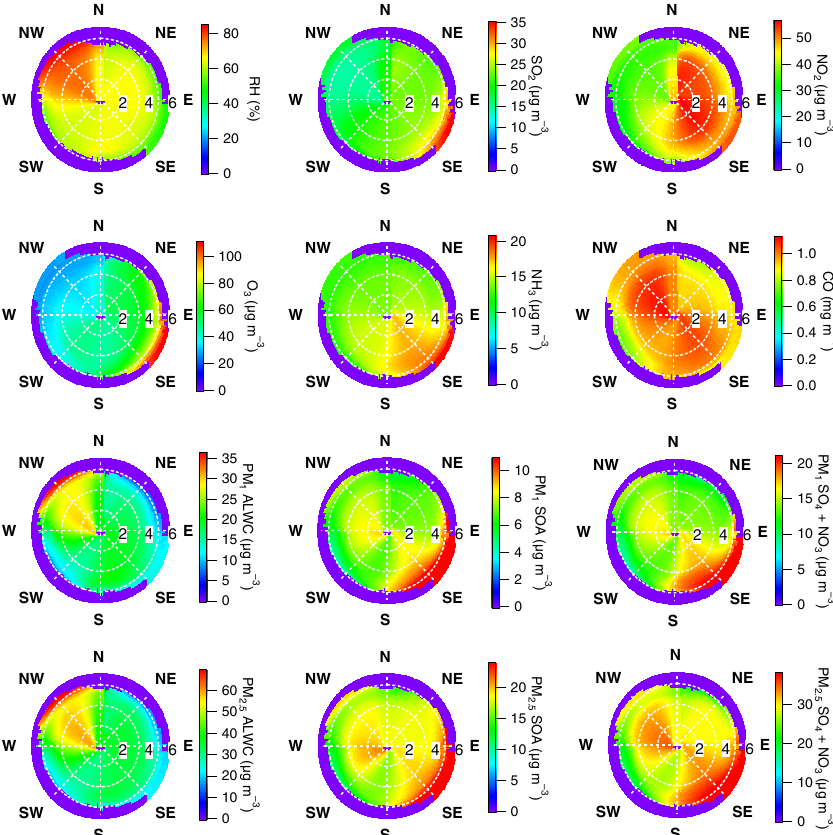
Figure 10. Wind analysis on relative humidity (RH), and gas-phase species (SO 2 , NO 2 , O 3 , NH 3 , and CO) and PM 1 and PM 2 . 5 ALWC, SOA, and [SO 4 + NO 3 ], respectively. Radius and angle of each plot refer to wind speed (ms − 1 ) and wind